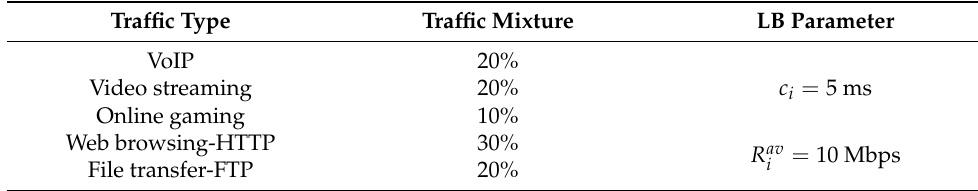
Table 2. Simulated traffic flows